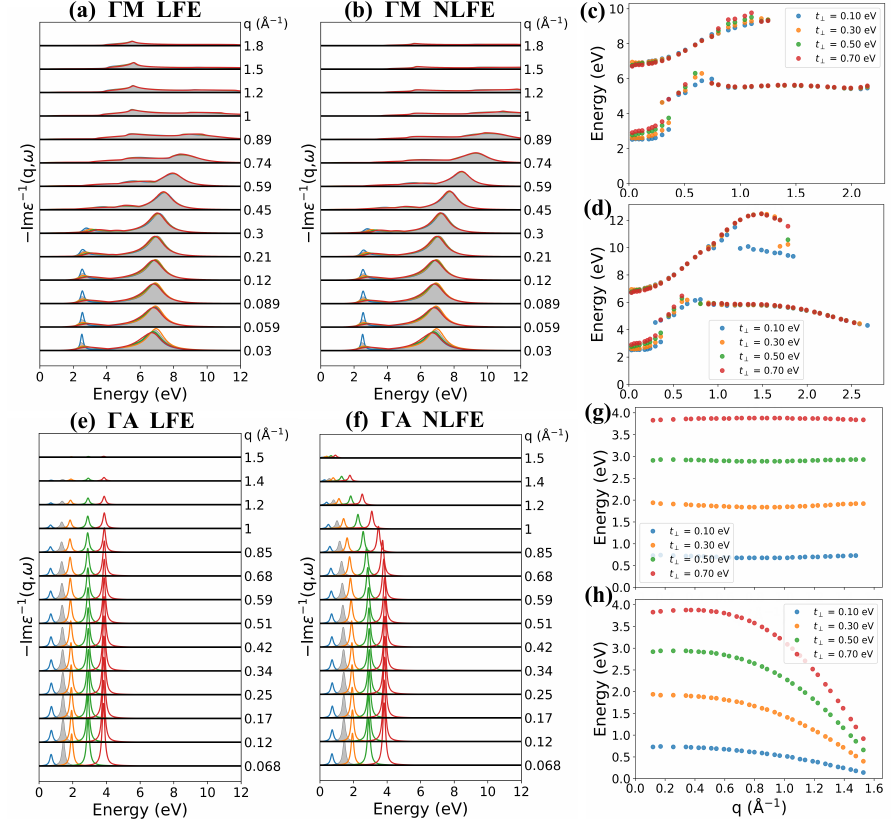
Figure 7. Calculated loss functions along the Γ M direction ( a ) with LFE, ( b ) without LFE and along the Γ A direction ( e ) with LFE, ( f ) without LFE at different interlayer hopping (light blue line for t ⊥ = 0.10 eV, orange line for t ⊥ = 0.30 eV, green line for t ⊥ = 0.50 eV and brown line for t ⊥ = 0.70 eV). ( c , d , g , h ) show positions of peaks of ( a , b , e , f ), respectively. The shaded background gives the loss functions of the no doping case for